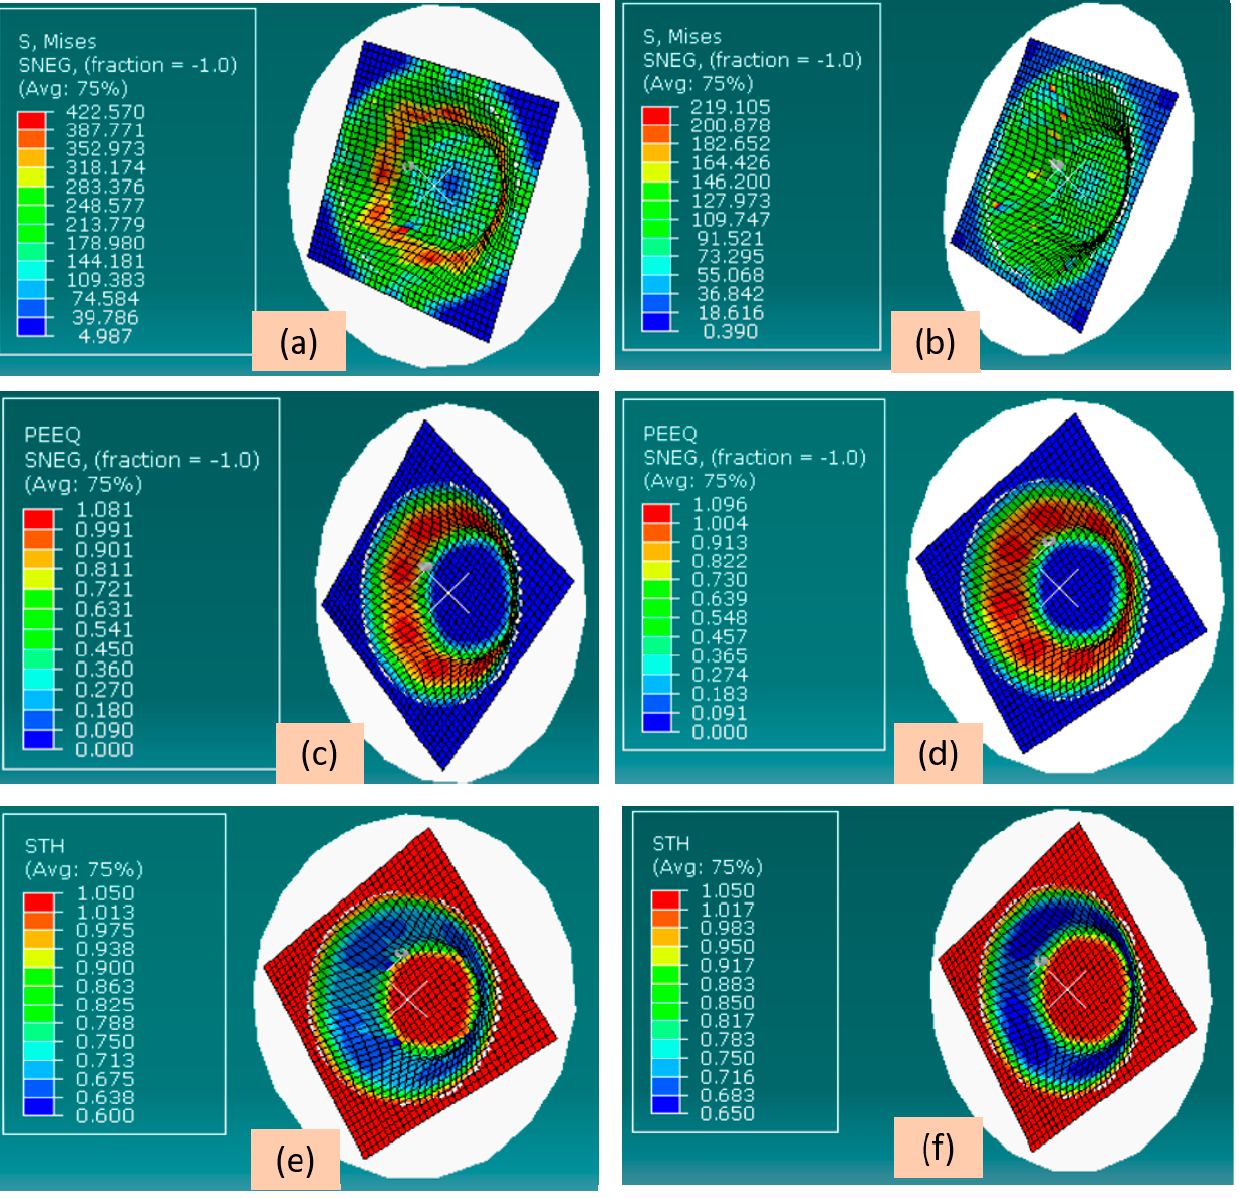
Figure 4. Simulation results of analysis on ABAQUS: ( a ) stress distribution in fabricated cone by CISF, ( b ) stress distribution in fabricated cone with CISF, ( c ) strain distribution in fabricated cone by CISF, ( d ) strain distribution in fabricated cone in WISF, ( e ) thickness variation along the wall of the formed cone in CISF, and ( f ) thickness variation along the wall of the formed cone in